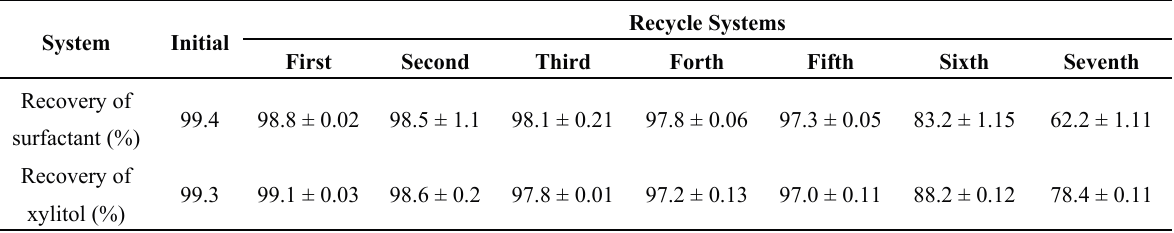
Table 4. The recycle recovery of surfactant and xylitol